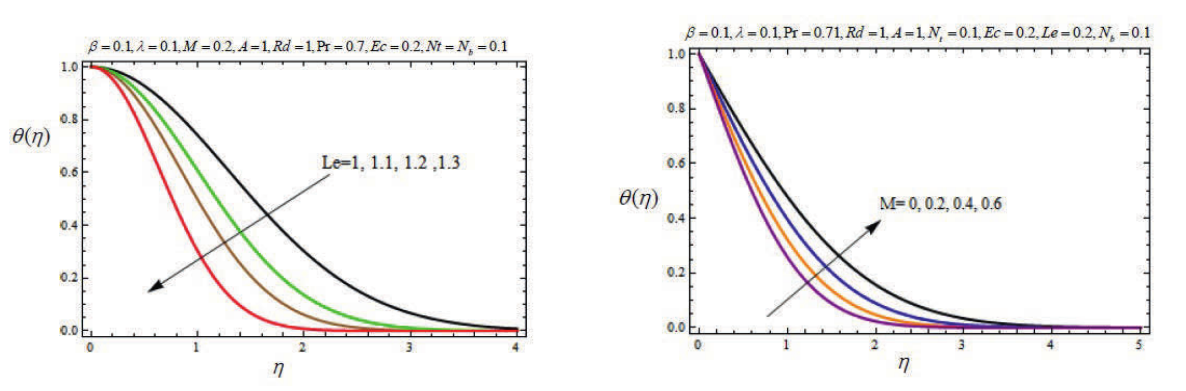
Fig. 10: Variation of temperature profile θ ( η ) with η for several val- ues of Lewis number Le .